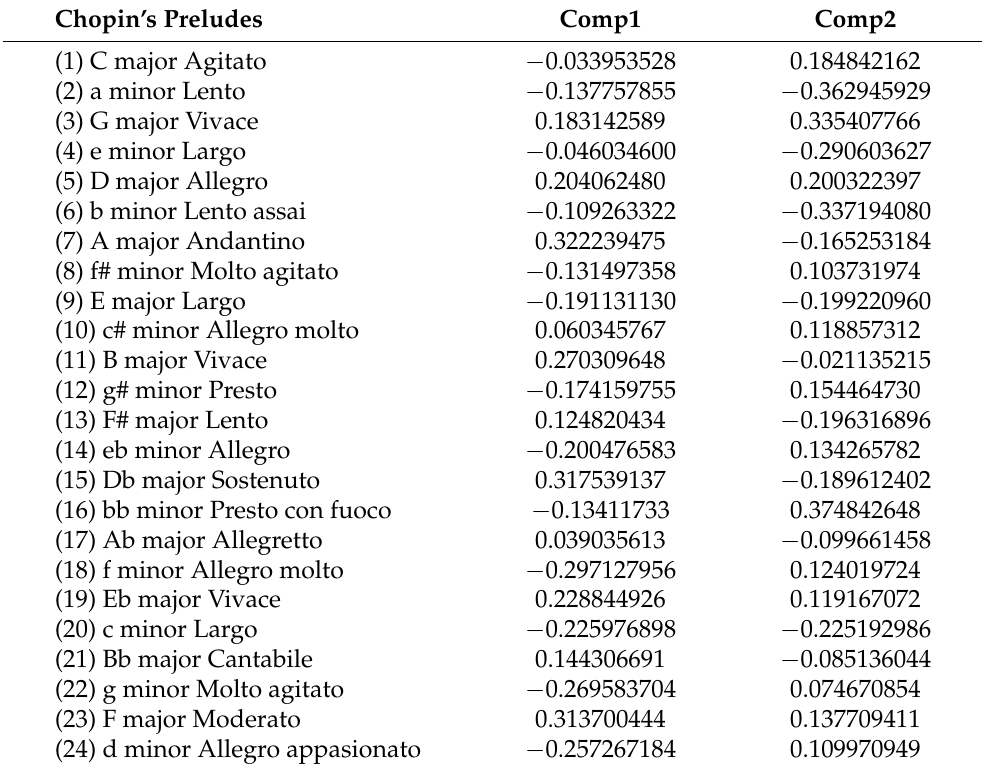
Table 19. Loading matrix A obtained with the TuckerALS algorithm for Chopin’s preludes data.